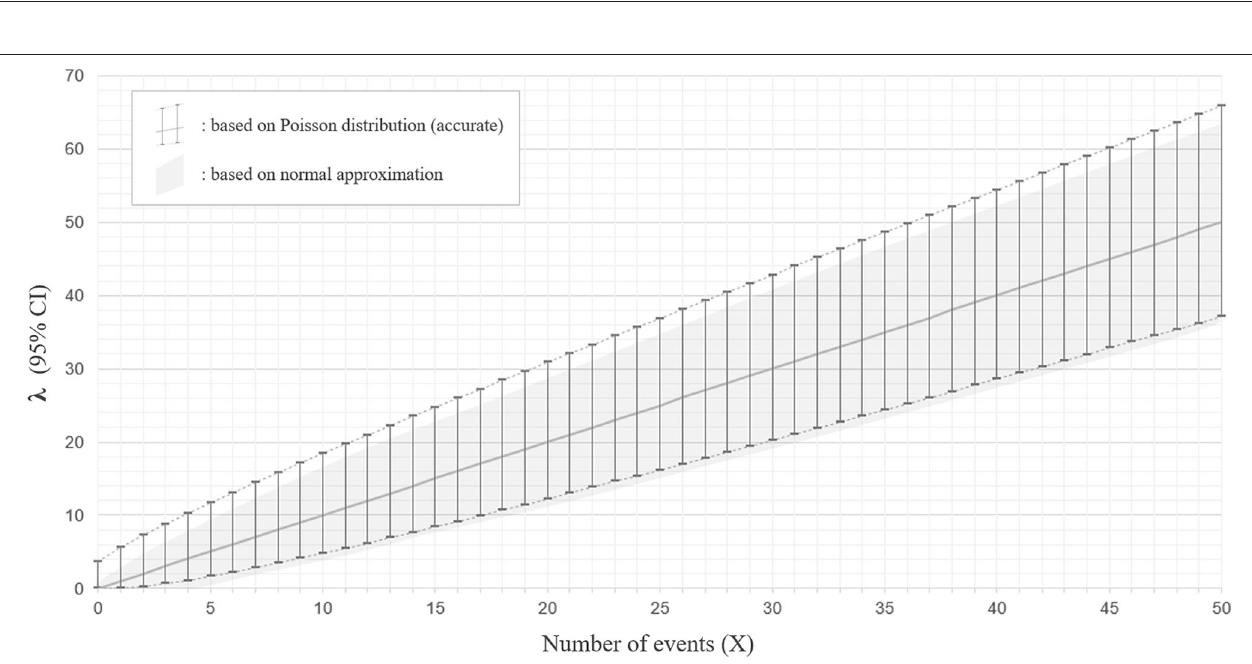
FIGURE 4 | Ninety five percentage confidence interval for the parameter λ with Poisson distribution and with normal approximation. The estimated 95% confidence intervals (CIs) for the mean λ with a different number of observed events ( X ) between 0 and 50, based on the Poisson distribution (accurate version; error bars with broken lines) or normal approximation (approximate version; gray color filled area), are shown. The estimated CIs for mean λ are not bilaterally symmetrical from X with the accurate version, whereas they are bilaterally symmetrical from X with normal approximation.